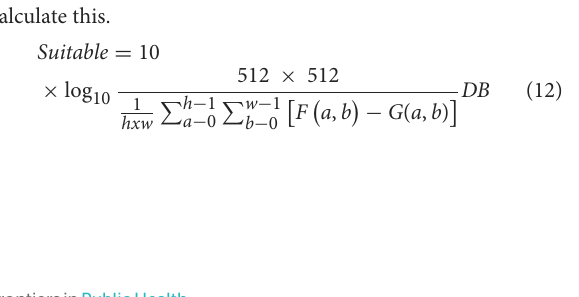
and denoised images. The following Eq. (11) is used to calculate this.